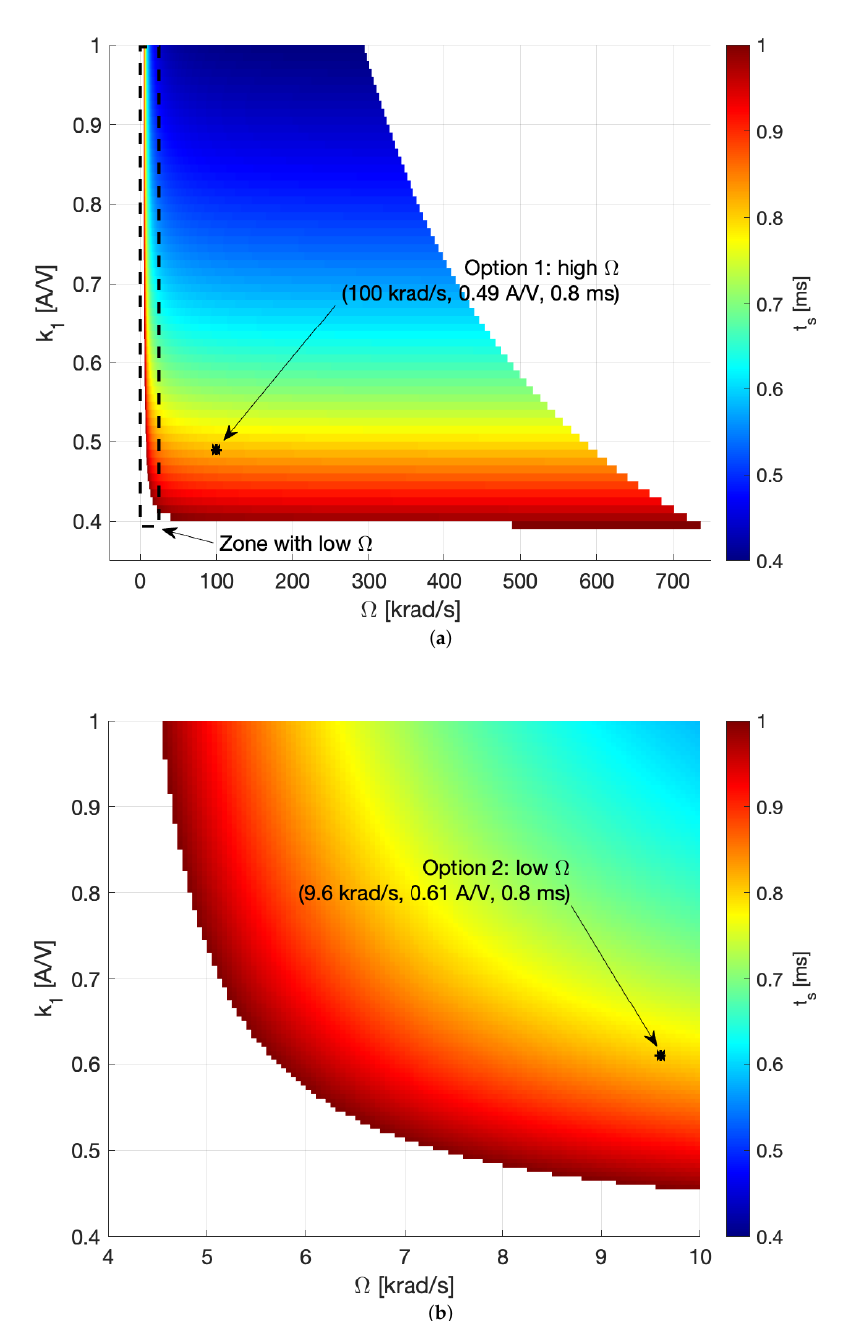
Figure 6. k 1 and Ω calculation to fulfill t s and SR f restrictions. ( a ) k 1 and Ω feasible values for t s < 1 ms. ( b ) k 1 feasible values with low Ω